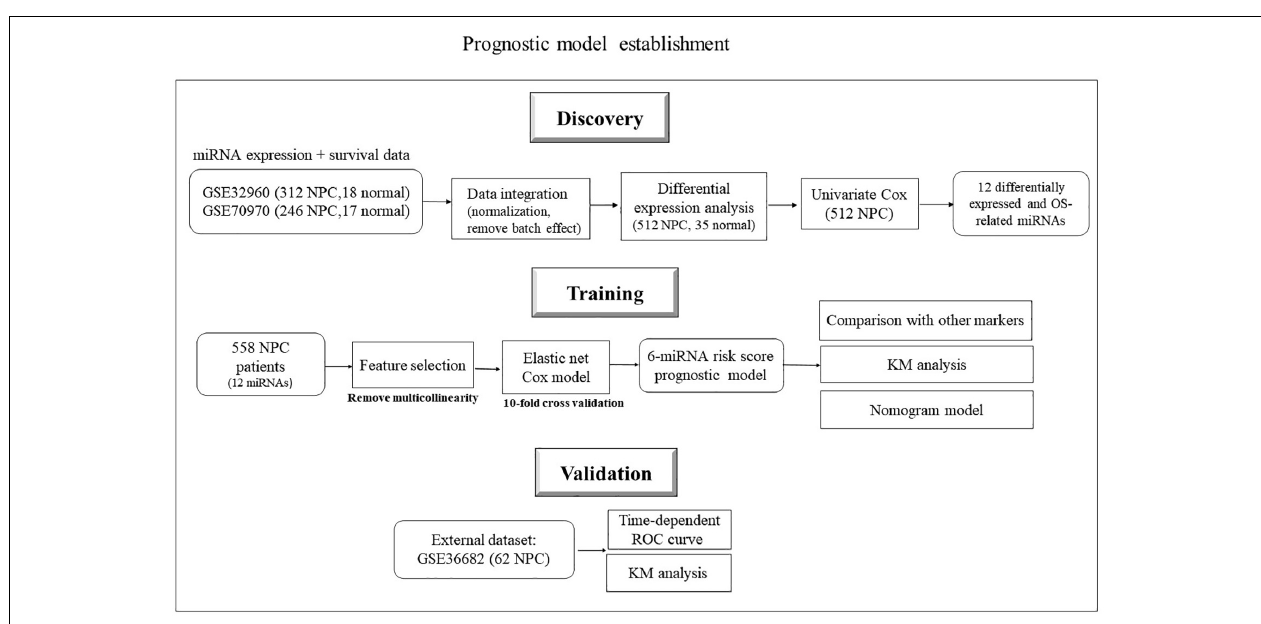
FIGURE 1 | Flowchart of data collection and